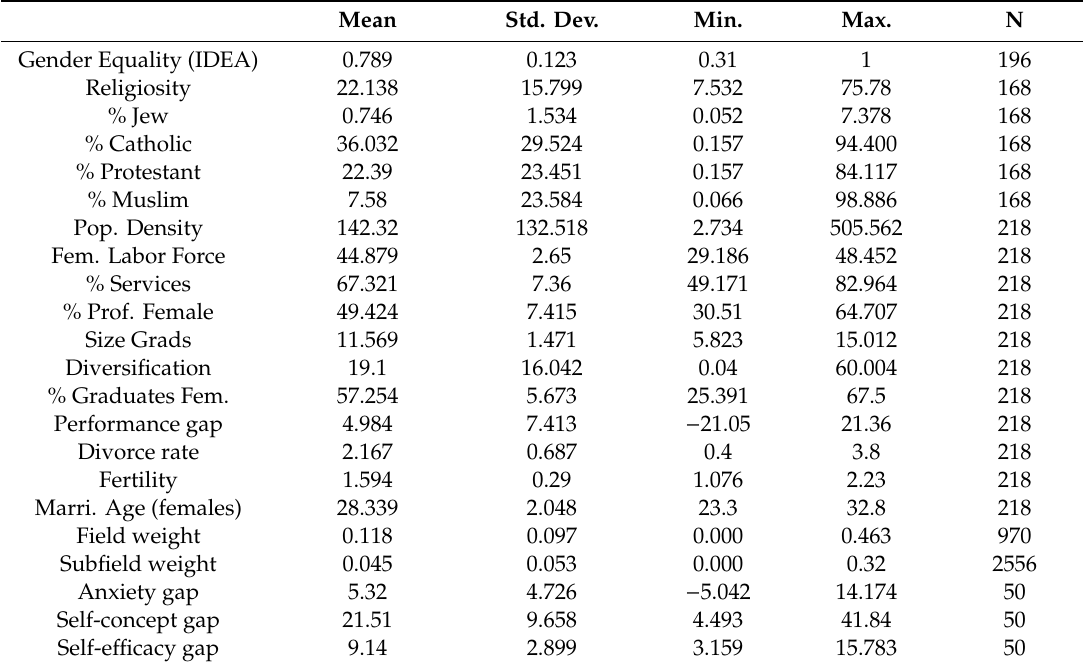
Table A2. Summary Statistics of Explanatory Variables.